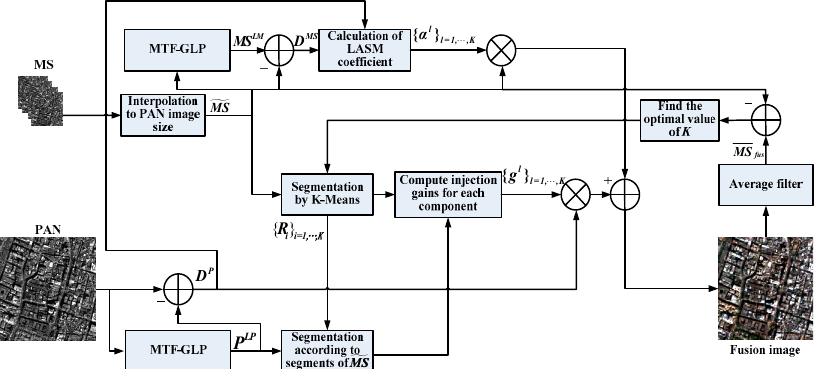
Figure 3. Flowchart of proposed pansharpening method. MTF-GLP, modulation transfer function matched generalized Laplacian pyramid.